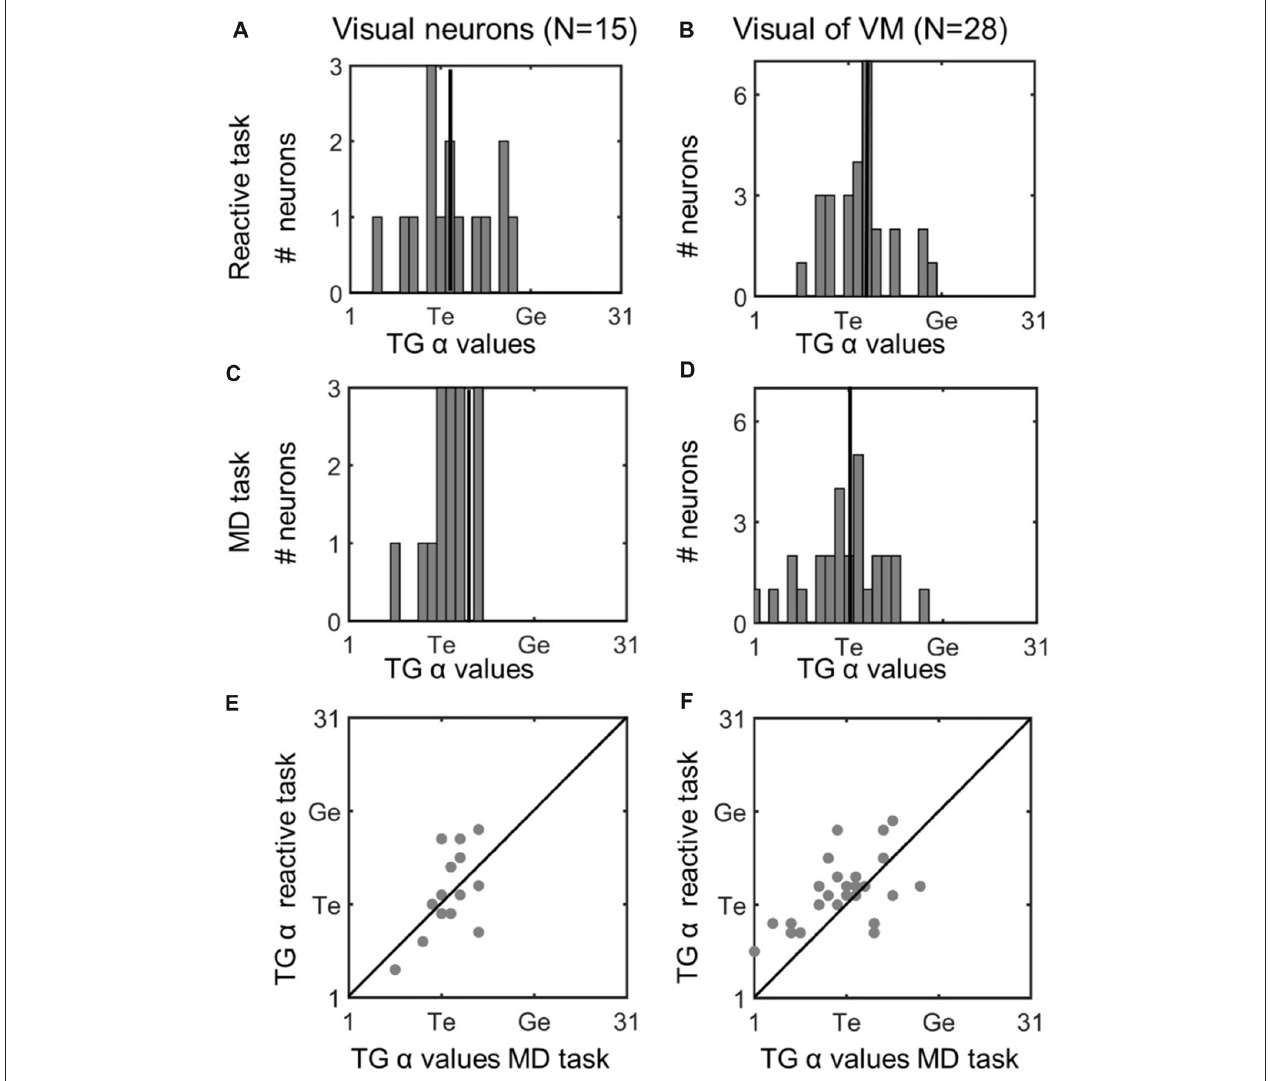
FIGURE 5 | Comparison of TG continuum coding of reactive vs. memory delay task in visual responses. Left column (A,C,E) : visual neurons; right column (B,D,F) : visual response of VM neurons. Top row (A,B) : TG value distributions in the reactive task. Vertical line indicates the median. Second row (C,D) : distributions for same neurons in the memory delay (MD) task. Visual neurons showed a more restricted distribution, but there was no significant difference between the TG values between the two tasks. Bottom row (E,F) : illustrates neuron-by-neuron comparison between the two tasks in the visual activity of Visual and VM neurons, respectively, plotting the TG continuum values from the reactive task as a function of the MD